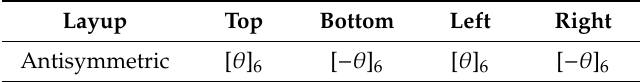
Table 4. The antisymmetric composite layup of the box